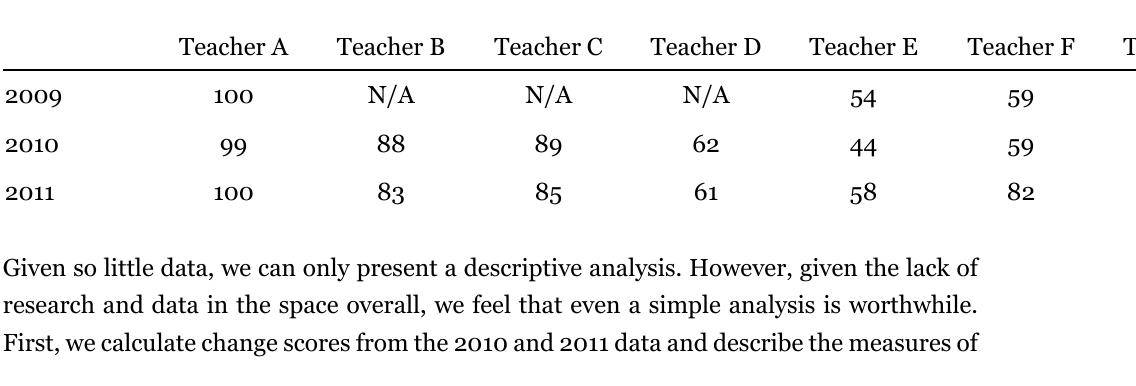
Summary of CRT Scores for Teachers Using Open Textbooks During Year 1